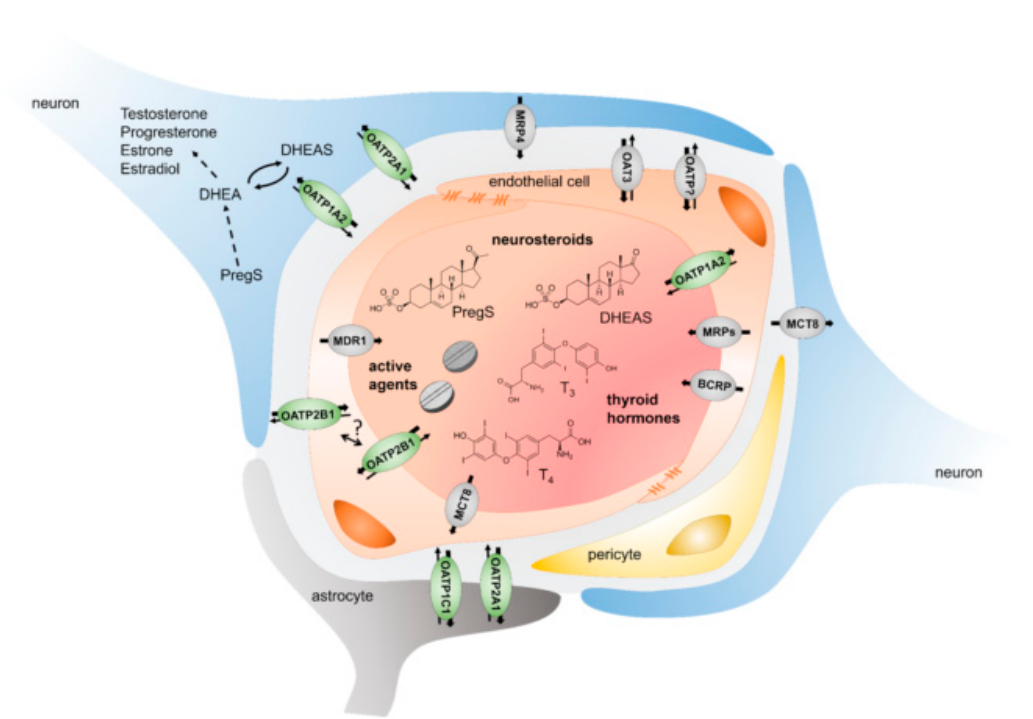
Figure 1. Schematic depicting the current understanding of uptake and efflux transporters at the blood–brain barrier. Uptake transporters enable the brain entry of molecules of endogenous (neurosteroids and thyroid hormones) or exogenous origin. Even if data on the localization of OATPs in the endothelial cells is sparse, OATP1A2 is assumed to be located at the apical membrane, while OATP2B1 might also be found at the basal membrane. Transcellular transport as well as protection involves efflux transporters such as MDR1 (ABCB1, P-Glycoprotein, P-gp), BCRP (ABCG2), and MRPs (ABCCs). Expression of OATP transporters and efflux transporters is also found in neurons and astrocytes enabling the movement of their substrates across these membranes. Adapted from with permission from [8], Biochem. Pharm. 2021.